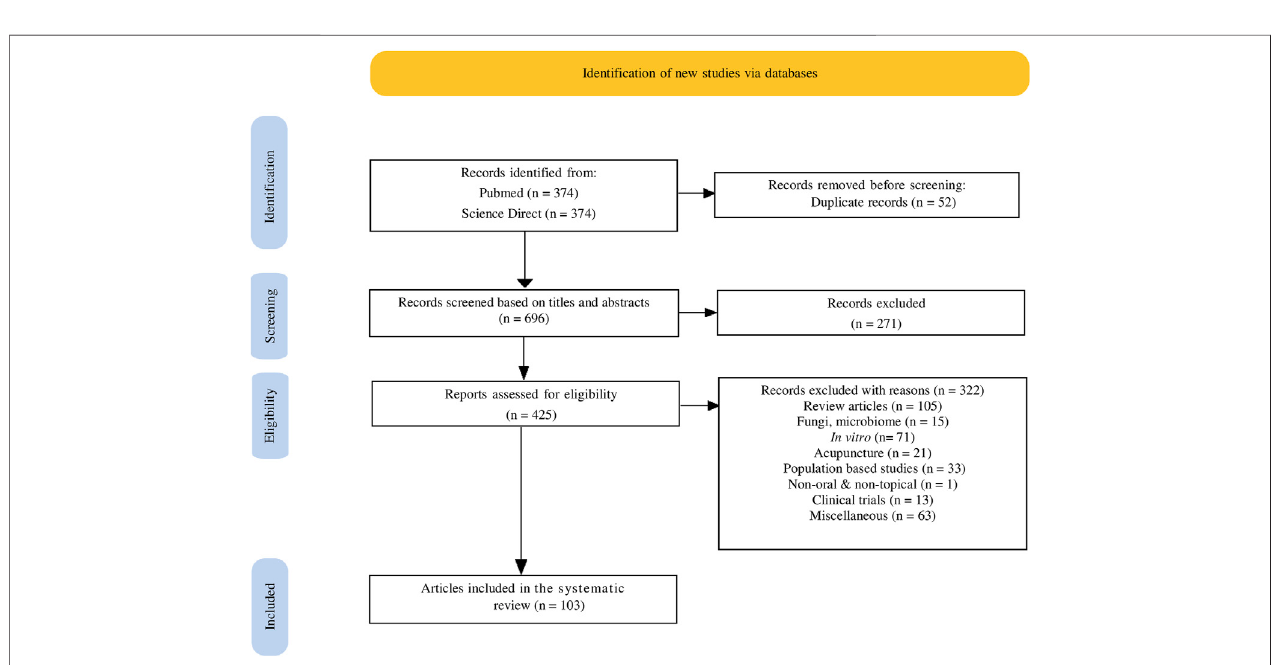
FIGURE 1 | Flow chart illustrating the search strategy and study selection process from Pubmed and Science Direct according to the PRISMA statement.